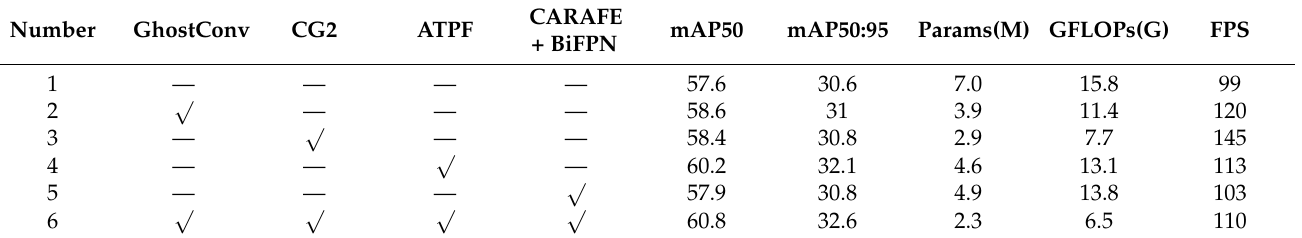
Table 2. Ablation experiments of CG-Net (NEU-CLS dataset).